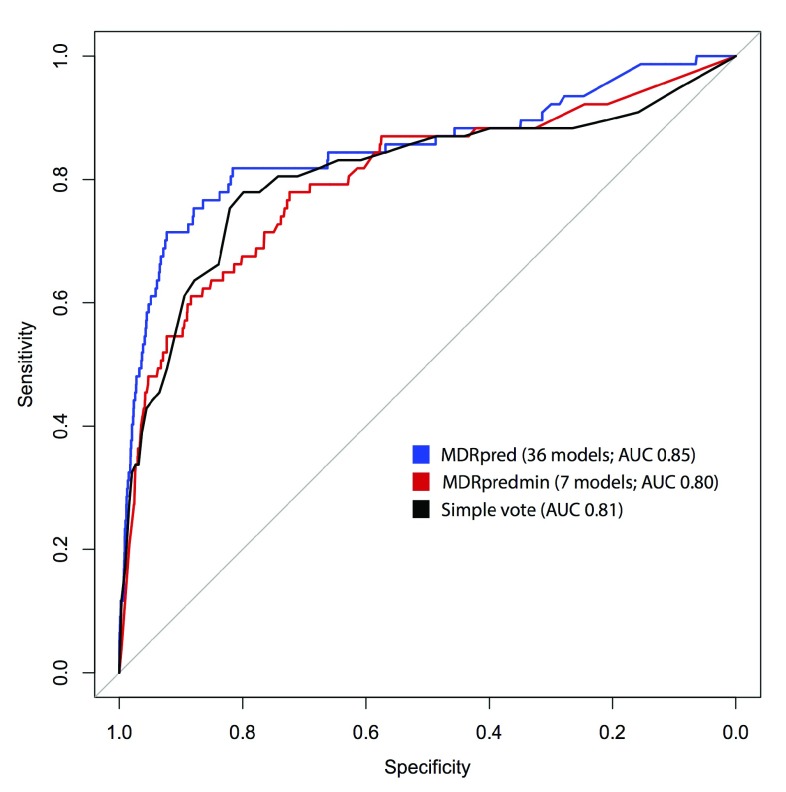
Comparison of MDRpred models.The receiver-operator characteristic curves (ROC) are shown for the simple vote combination of 36 models (black line), the logistic regression combination of 36 models (blue line), and the logistic regression combination of the selected seven models shown in
Table 3 (red line). The area under the curve (AUC) for each method is indicated in the legend. The results show that using all models in a score derived by logistic regression provides the best performance, though the other methods also perform adequately.